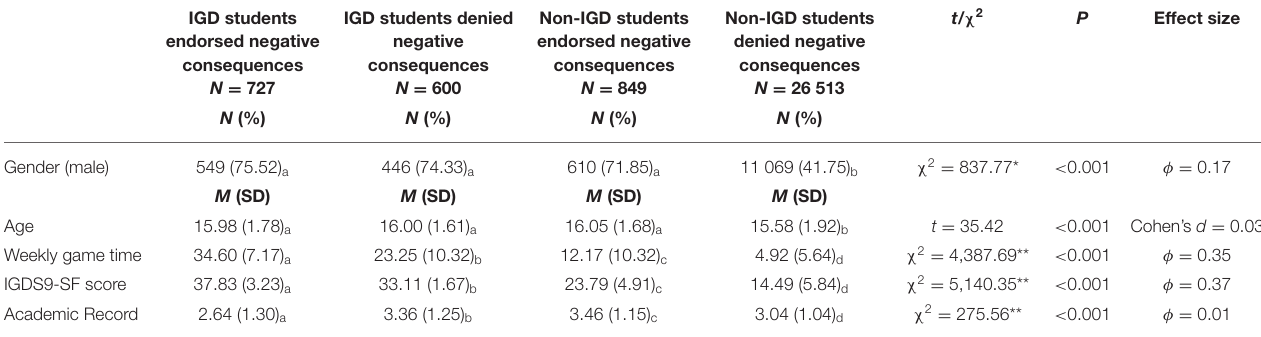
TABLE 4 | Comparison variables of impairment for IGD ( n =